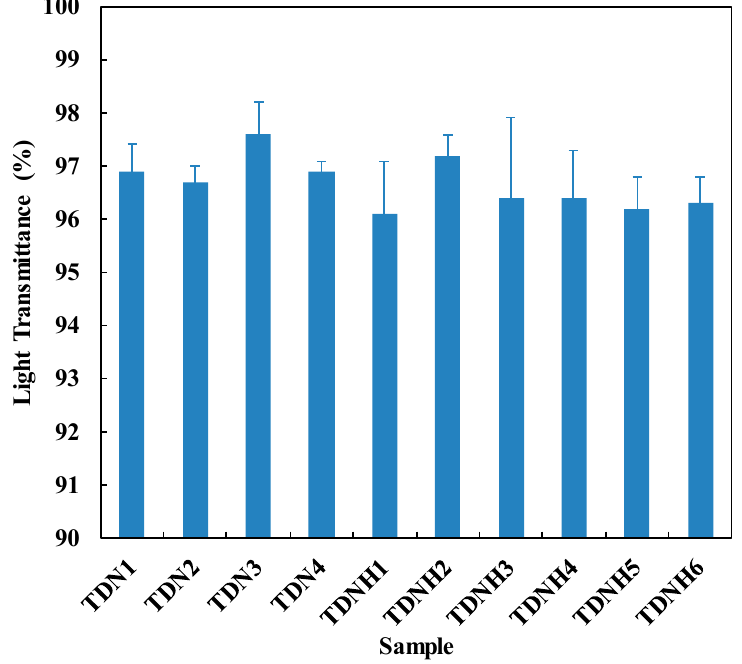
Figure 2. Light transmittance of hydrated modified silicone hydrogel